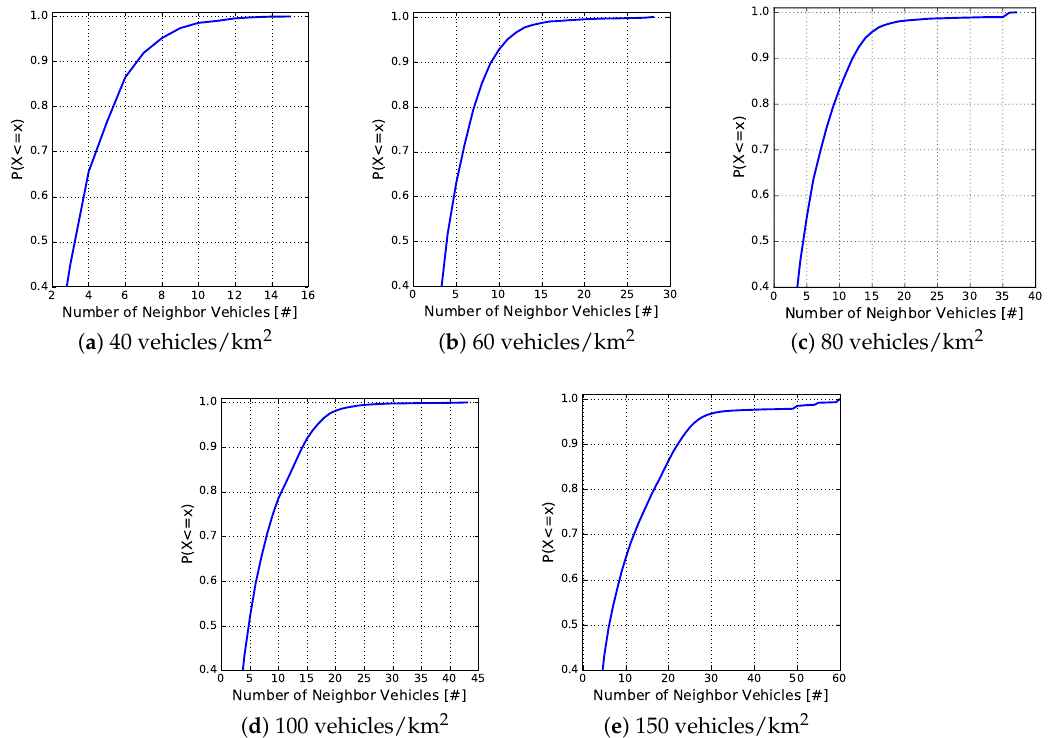
Figure 9. CDF of the number of one-hop neighbours in relation to the vehicle traffic